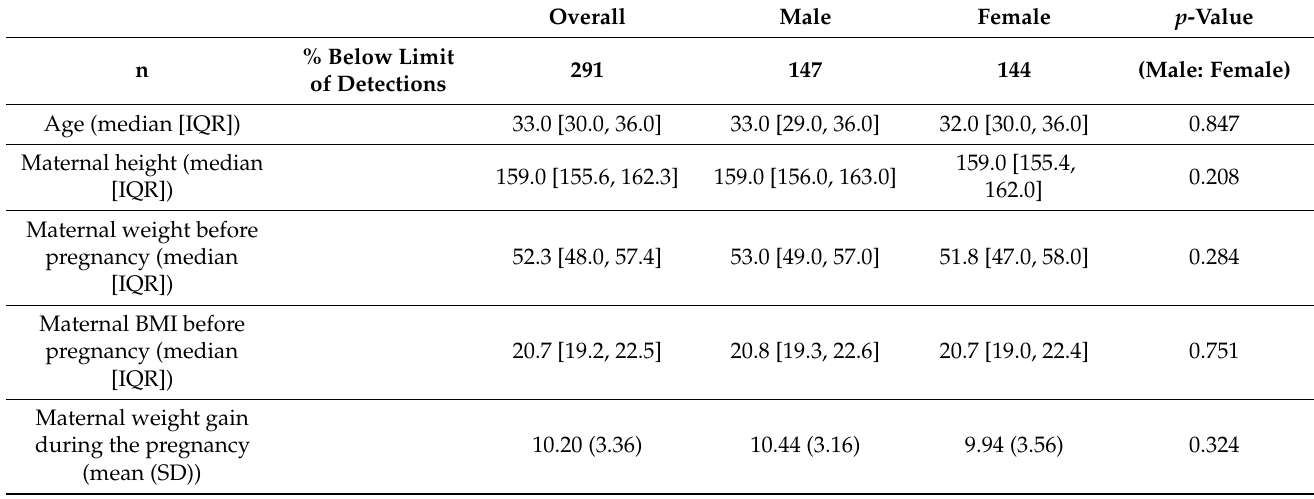
Table 1. Individual details of